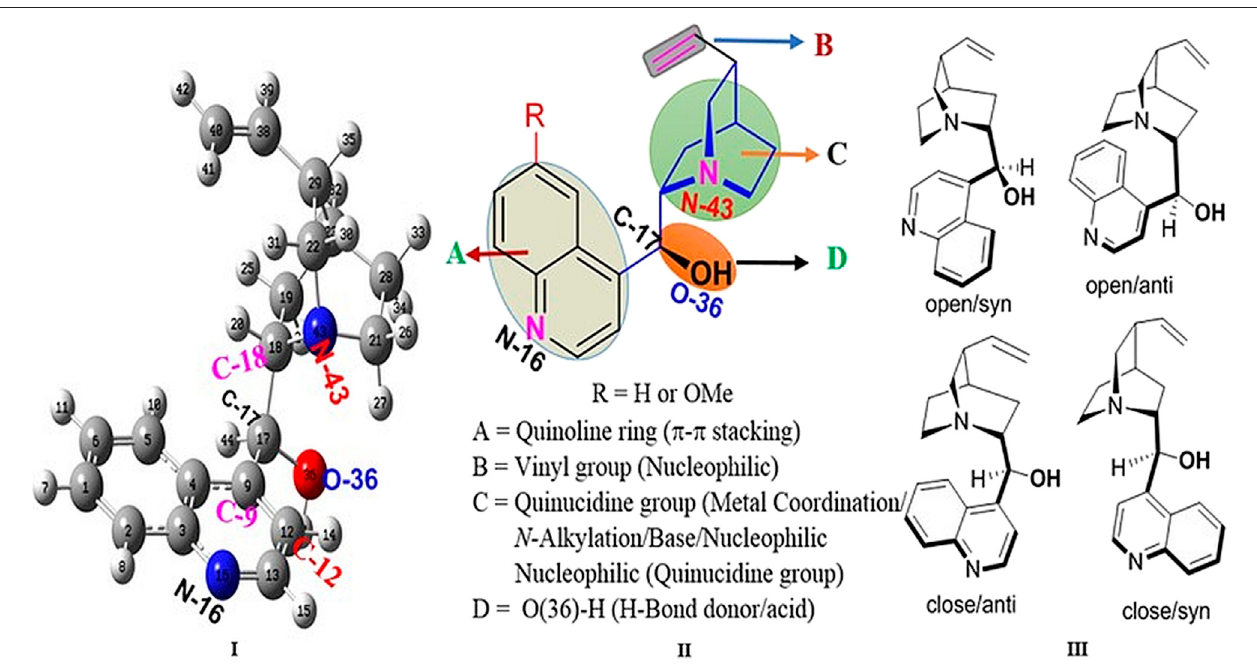
FIGURE 1 | Reactive sites of cinchona alkaloids and the representative conformations of epi-cinchonidine ( right: syn/anti, open/close; left: optimized geometry with the atomic number).